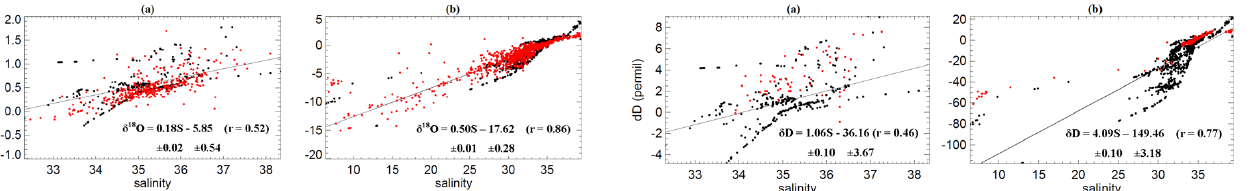
Fig. 12. Relationship between δ D and salinity S for simulated and observed surface waters. (a) Tropical regions, (b) extra-tropical re- gions. In all panels, model results are plotted in black and obser- vational data are plotted in red. The regressions are calculated from simulation results. Please note that the same grid cells as used in the δ 18 O- S analyses (Fig. 11) have been selected to determine the δ D- S relations in tropical and extra-tropical oceans (see text for further